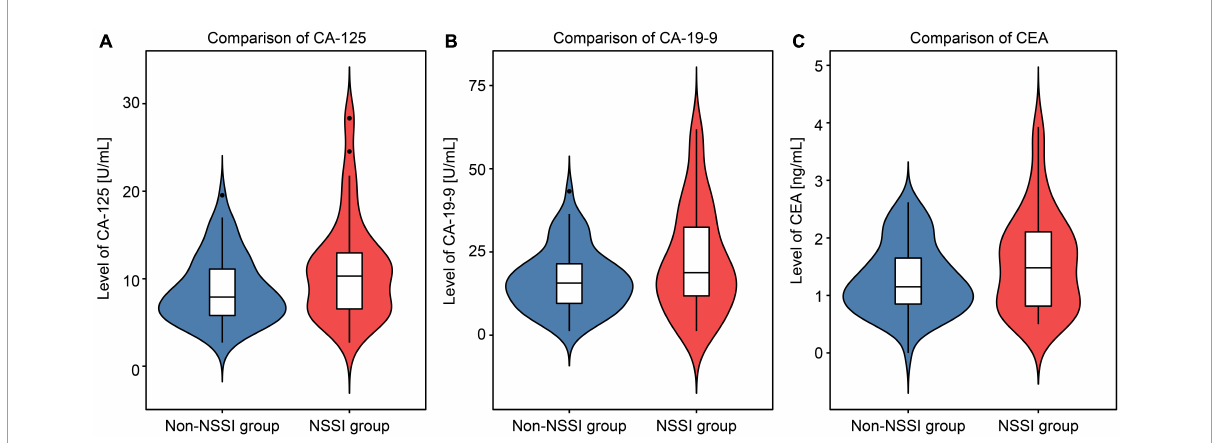
FIGURE2 Violin chart comparing the levels of cancer antigen 125 (CA-125), cancer antigen 19-9 (CA19-9), and carcinoembryonic antigen (CEA) between the non-suicidal self-injury (NSSI) and non-NSSI